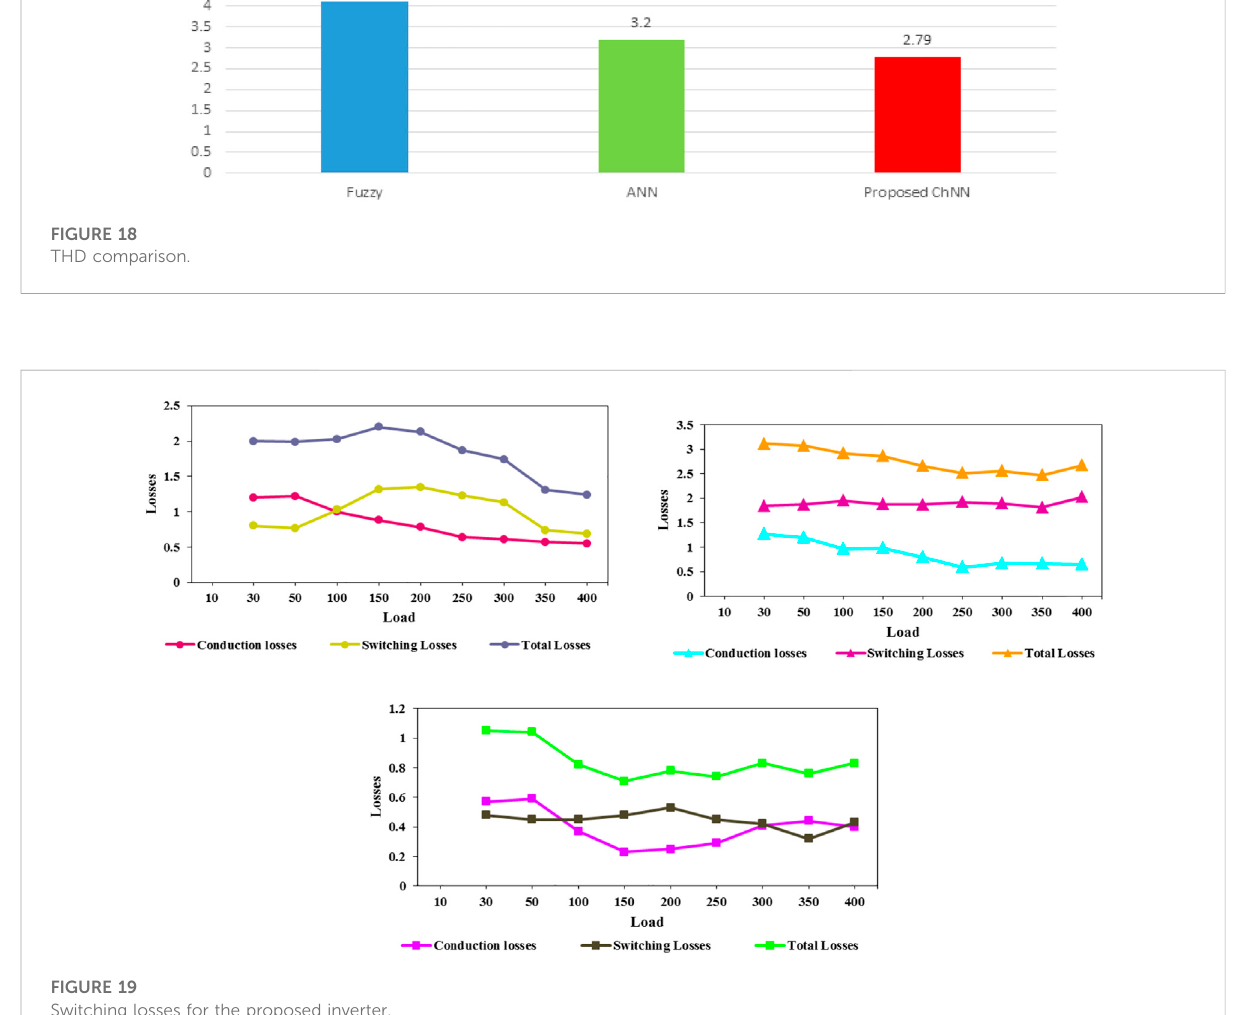
FIGURE 19 Switching losses for the proposed